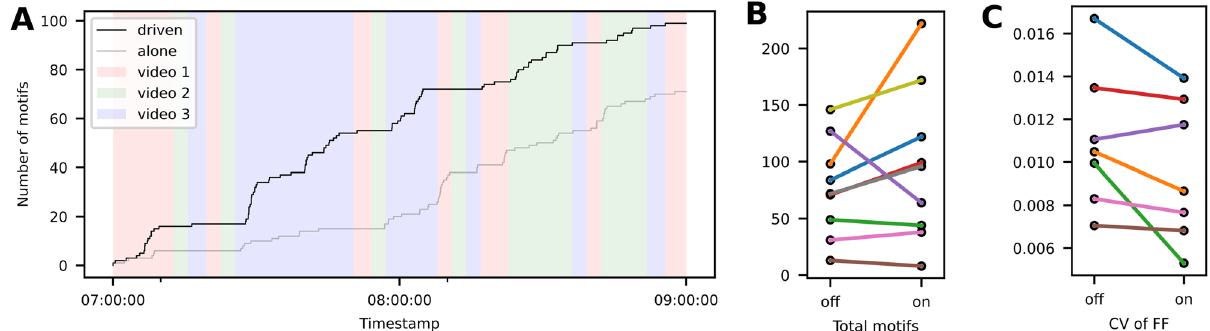
Figure 6. Number of directed motifs can be increased using real-time motif detection. ( A ) Cumulative sum of detected motifs for one bird during a 2-h period of driving the behaviour by switching virtual female individuals and the same 2 h on the following day without video. Background colours show which video was playing during that time. Videos change dynamically based on number of motifs. ( B ) The number of motifs sung was significantly higher (Wilcoxon signed rank test 5% significance level, n = 8 , W = 33 , p = 0.0195 , CLES = 0.625 ) during the 2 h with video compared to the 2-h control without video demonstrating that the video drives them to sing more. ( C ) The coefficient of variance for the fundamental frequency showed a trend to be lower (Wilcoxon signed rank test 5% significance level, n = 7 , W = 4 , p = 0.0547 , CLES = 0.612 ) during the 2 h with video compared to the 2-h control. Colored lines in ( B ) and ( C ) indicate (Fig. 6C). Taken together, our system made the birds sing (i) directed motifs and (ii) more so in 2 h compared to undirected motifs in the control period, thus demonstrating the ability to drive directed singing behaviour.